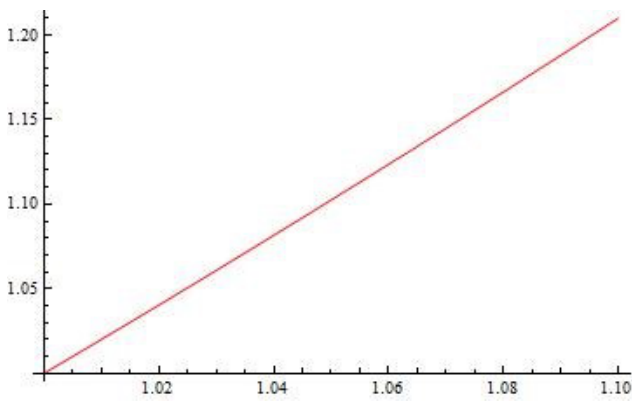
Fig. 3 Graph of the solution using AIM for the interval [ 1 , 1 . 1 )